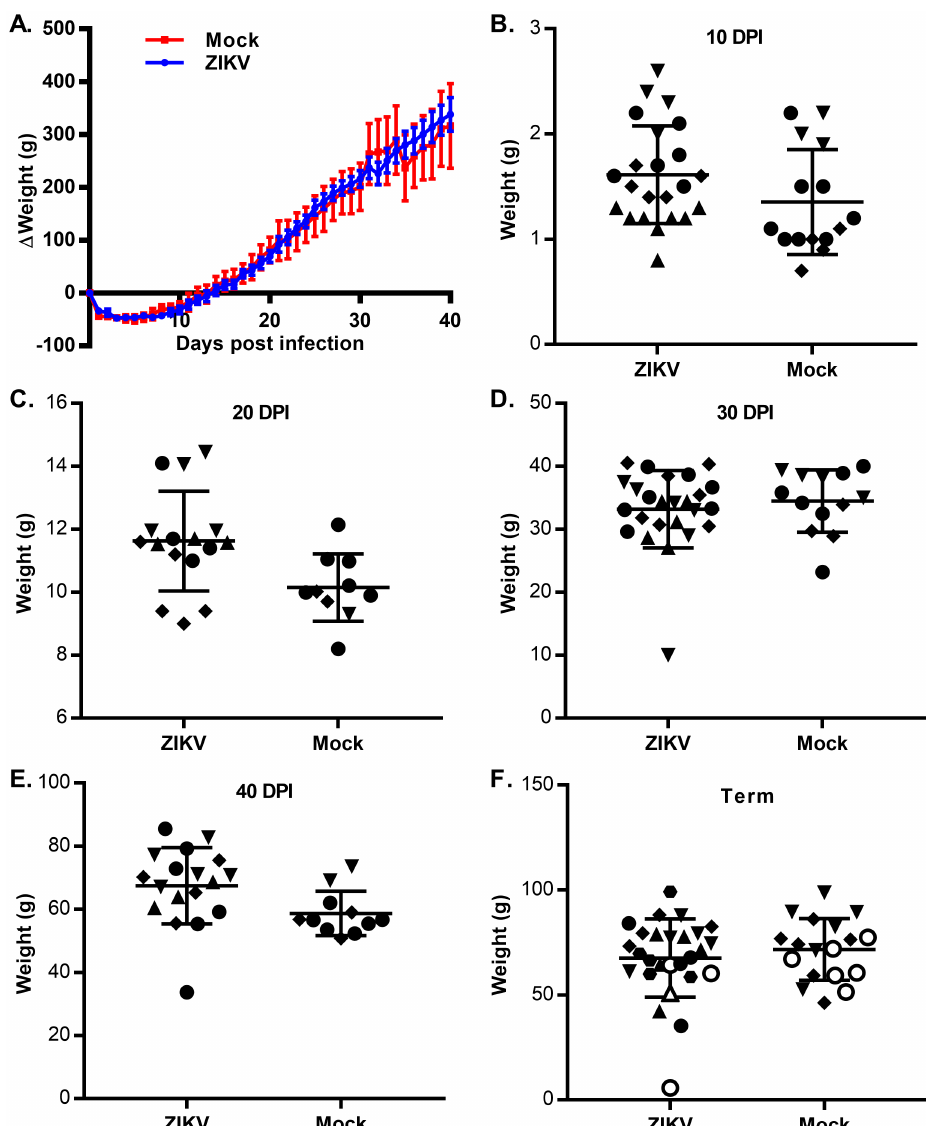
Fig 3. ZIKV infection of pregnant guinea pigs. Pregnantguineapigs were infected with 1X10 7 PFU of ZIKV (N = 21) or sham injected (N = 15) at GA 18–21. (A) Guinea pigs were weigheddaily until a pre-determined experimental endpointand the mean weight changefor each group was plotted along with the standarderror. Animalswere euthanized at 10, 20, 30 or 40 days post-infection (N = 4 infected, 3 uninfectedper group) or euthanized on the day of delivery (N = 5 infected, 3 uninfectedper group). (B-F) Pups were weighedat the indicatedendpointpost-infection. Symbol shaperepresents individual litters; open symbols indicate pups born dead. The bars indicatethe standard error within each